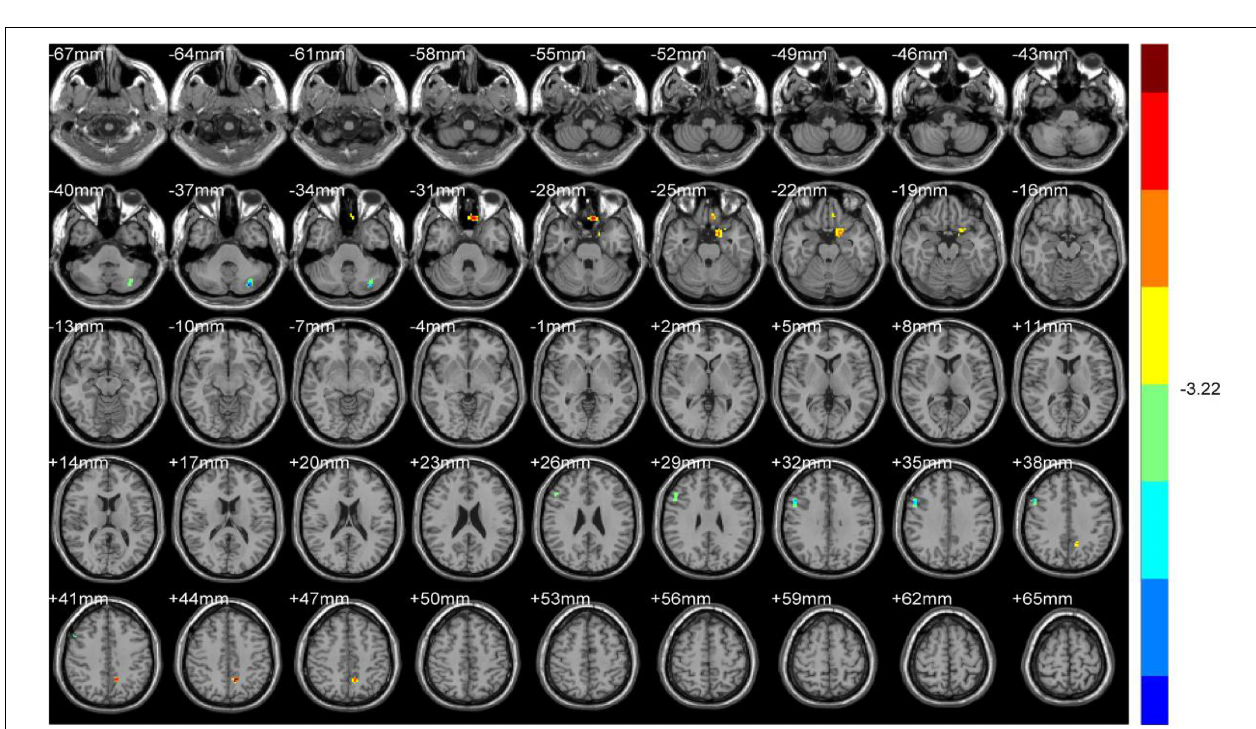
FIGURE 5 | ReHo (Non-dominant hemisphere vs.